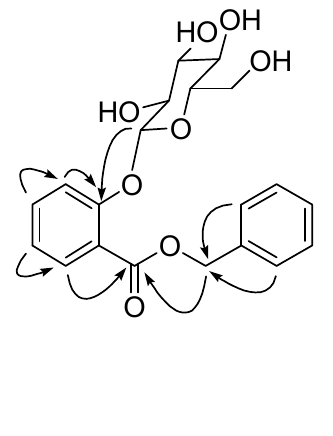
Figure 2. Key HMBC correlations of